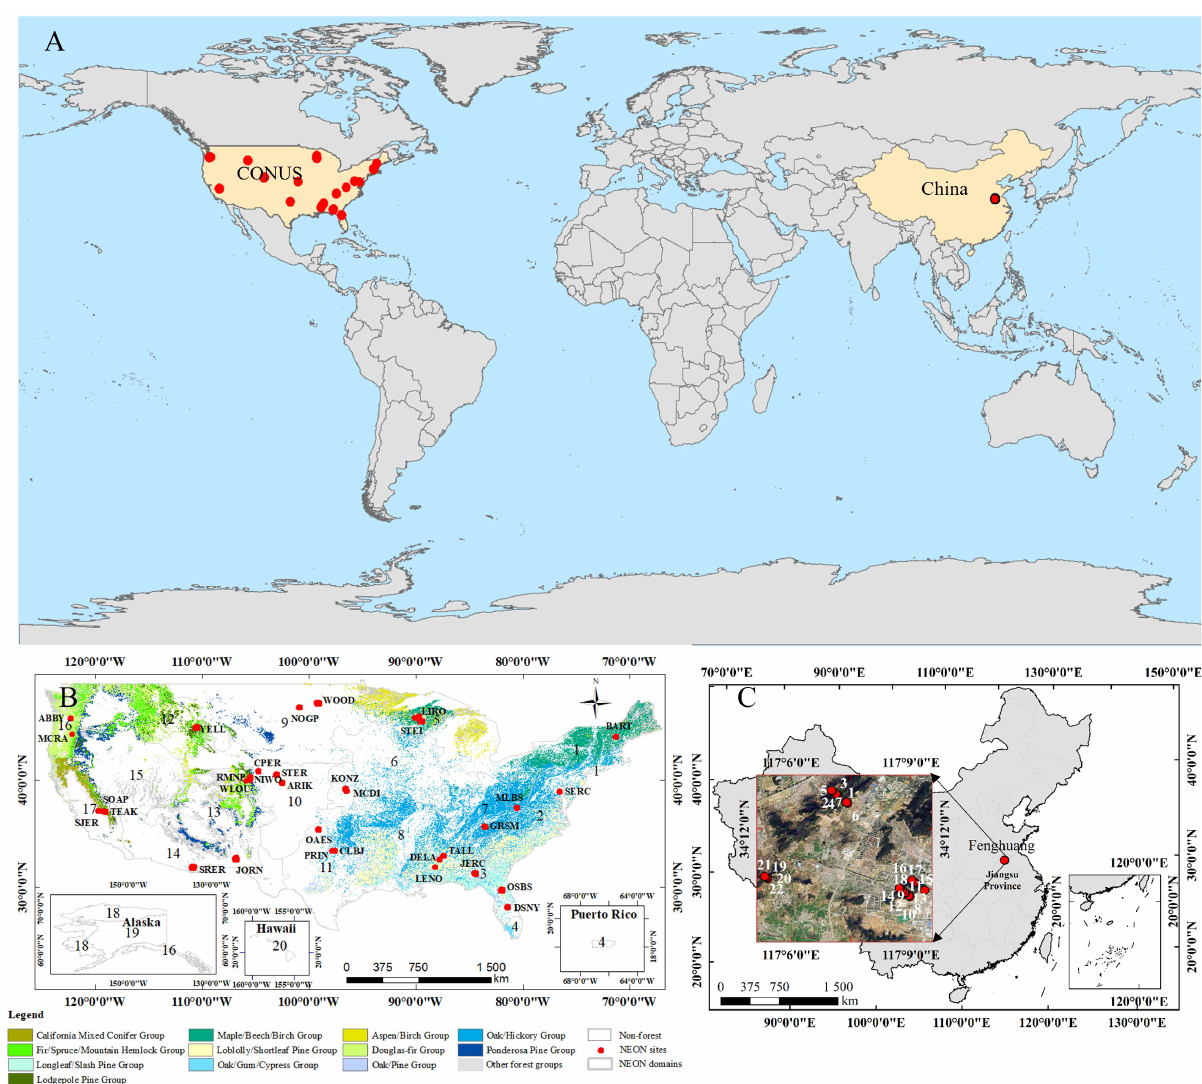
Figure 1. The distribution of study areas ( A ) including 22 NEON sites across the CONUS ( B ) and field-measured plots located in the Fenghuang Mountains in China ( C ). The red points in ( A ) were NEON sites in the COUNS and location of the Fenghuang Mountains in China. The numbers in ( B ) were identifications for the eco-climate region in the U.S.A. The red rectangle in ( C ) was the boundary for the field survey around the Fenghuang Mountains, while the red points in ( C ) were plot locations. The white number showed the field plot ID. The true color images were downloaded from google